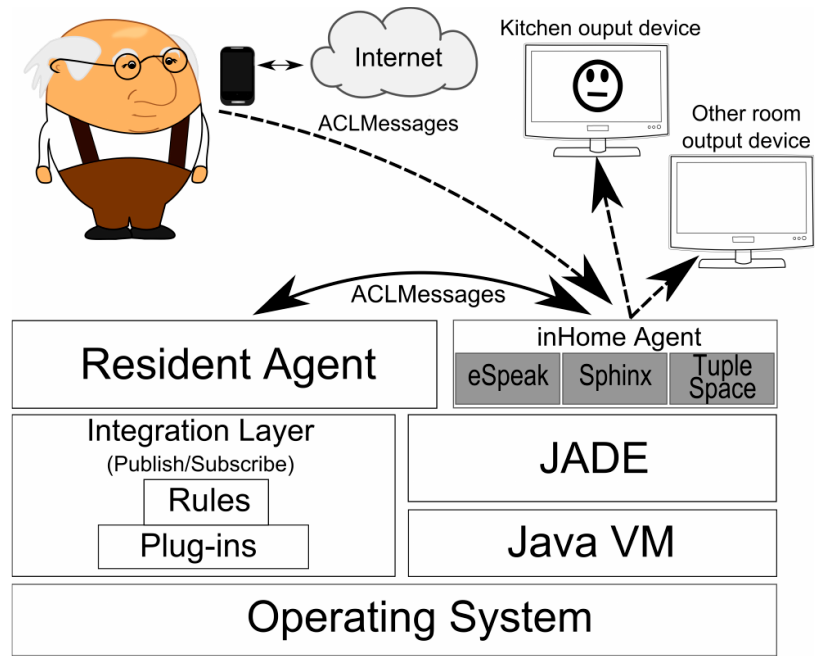
Figure 8. InHandheld Agent in the software